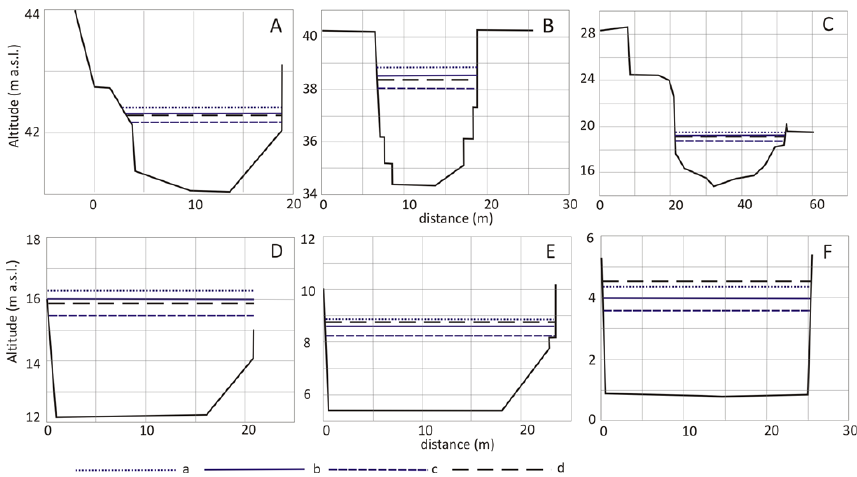
Fig. 2. Hydraulic cross sections and water surface elevations (redrawn from Provincia di Genova, 2002): (a) return period on 500yr; (b) 200 yr; (c) 50yr; (d) flood marks surveyed (1 June 2007).